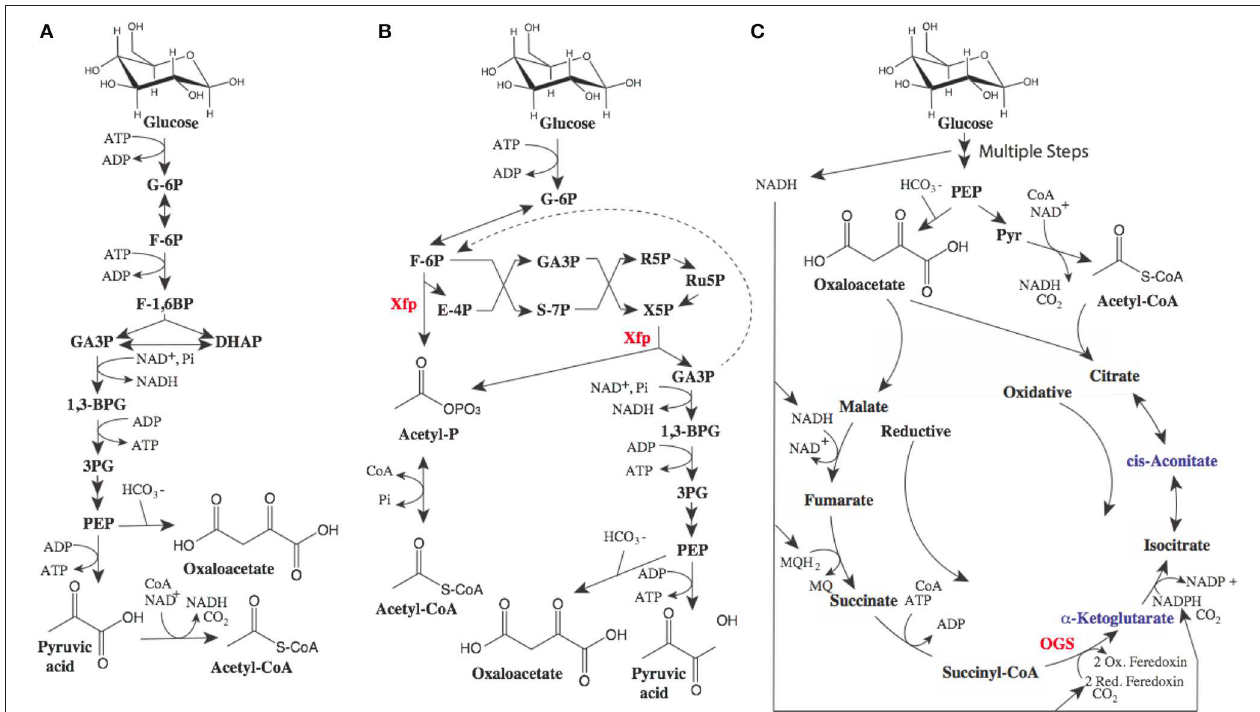
FIGURE 2 | Potential metabolic pathways to optimize MA yields. (A) glycolytic metabolism, (B) Bifidobacterium shunt, and (C) reductive TCA cycle. In glycolysis (A) 0.5 moles of glucose are converted to 1 mole of pyruvate (or alternatively 1 mole of oxaloacetate) and one mole of NADH (1 pair or electrons). Pyruvate can be oxidized to acetyl-CoA generating another mole of NADH. (B) The Bifidobacterium shunt phosphoketolase enzyme (xfp) (Fandi et al., 2001) has activity as both an erythrose-4-phosphate (E4P) and xylulose-5-phosphate (X5P) phosphoketolase producing acetyl-phosphate (acetyl-P). Recycling 2 moles of glyceraldehyde-3-phosphate (GA3P) through triosephosphate isomerase and the reversible fructose bisphosphate aldolase can lead to improved yield (dashed line) (C) . Inclusion of 2-oxoglutarate synthase (OGS) in anaerobic production could lead metabolism where oxidative flux through the TCA cycle is balanced by reductive flux wherein electrons from glycolysis are consumed. Balanced TCA flux can lead to higher yields of alpha-ketoglutarate derived products such as mesaconic acid as well as cis-aconitate derived products such as itaconic acid. Additional abbreviations: glucose-6-phosphate (G-6P), fructose-6-phosphate (F-6P), fructose-1,6-bisphosphate (F-1,6BP), dihydroxyacetone phosphate (DHAP), 1,3 bisphosphoglycerate (1,3BPG), 3 phosphoglycerate (3PG), phosphoenolpyruvate